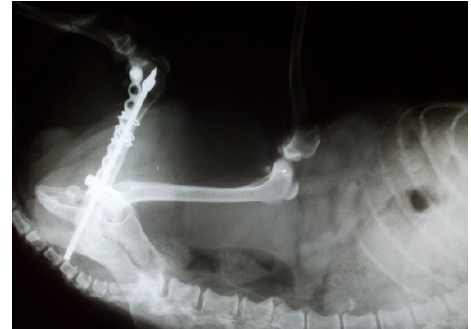
Fig. 6. Lateral radiography showed finish of operation